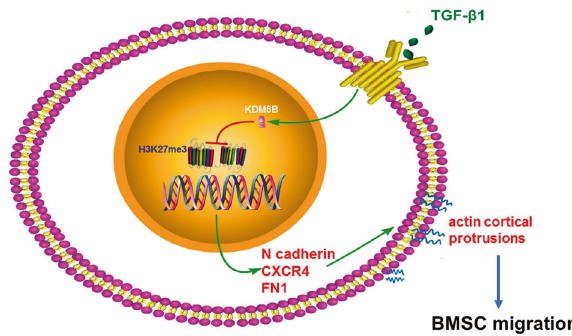
Fig. 5 Mechanism diagram of TGF- β 1-induced BMSCs migration. A summary diagram for TGF- β 1 induced BMSCs migration via histone demethylase KDM6B mediated inhibition of methylation marker